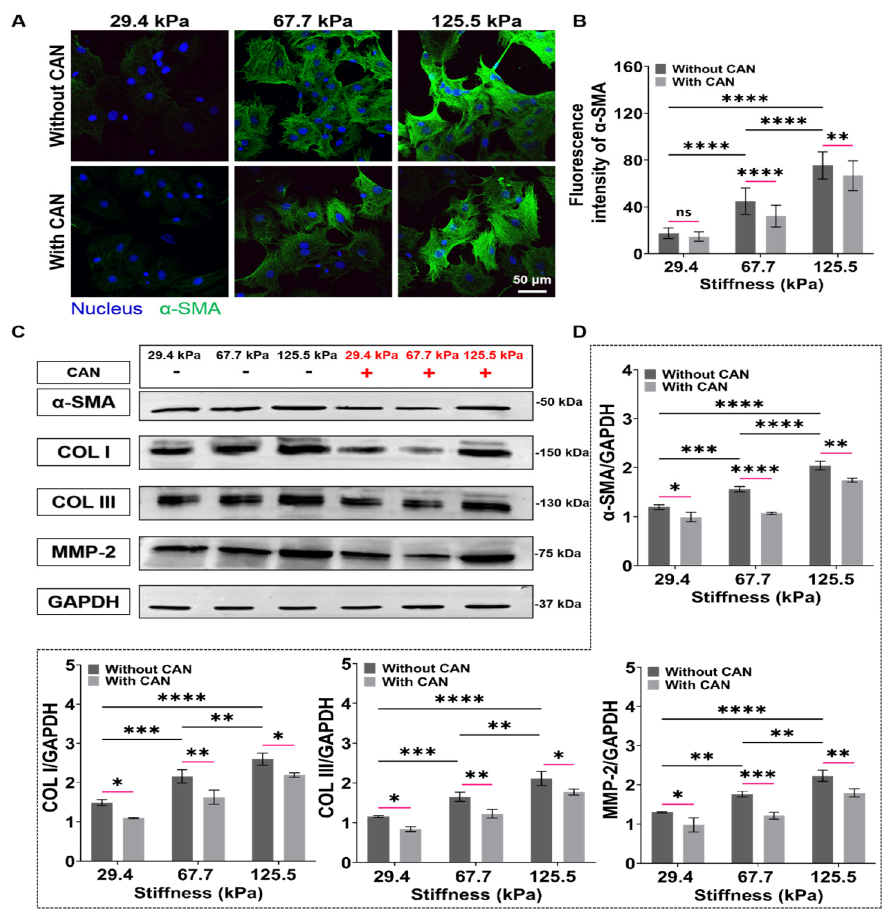
Figure 6. Characterization results of activation and collagen-related proteins of CFs on PA gels with a stiffness of 29.4, 67.7, and 125.5 kPa. ( A ) α -SMA fluorescence images of CFs on PA gels with dif- ferent stiffness without and with CAN treatment. ( B ) Statistical histogram of α -SMA fluorescence intensities expressed by CFs ( n > 3). ( C ) Relative protein levels of α -SMA, type I and type III colla- gens, and MMP-2 of CFs on PA gels with different stiffness without and with CAN treatment de- termined by western blotting analysis. ( D ) Statistical histogram of protein gray values of α -SMA,